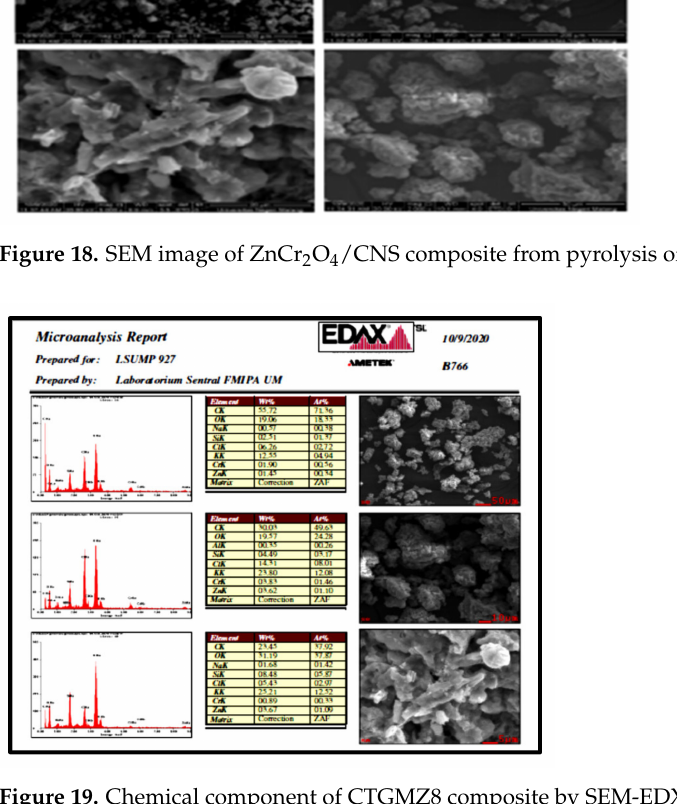
Figure 19. Chemical component of CTGMZ8 composite by